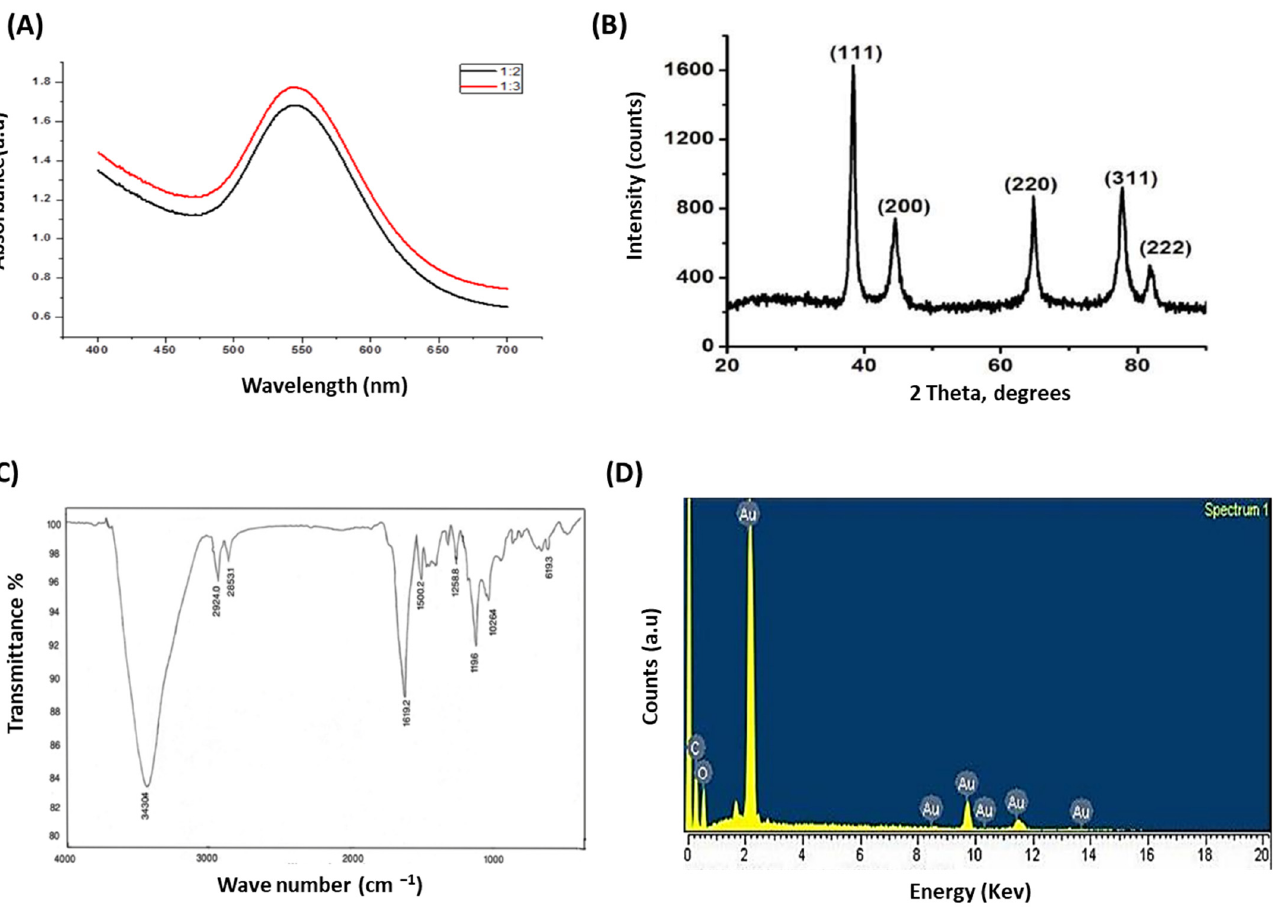
Figure 2. Confirmation of biosynthesized LH-AuNPs. ( A ) UV–Vis spectrum of LH-AuNPs. Different ratios give different absorption peaks, but the most extreme peak with maximum absorbance was recorded 1:2 on 544 nm. ( B ) XRD spectrum recorded for LH-AuNPs showed clear peaks of cubic phases at 38.2 (111), 44.3 (200), 64.9 (220), 77.5 (311), and 81.5 (222), which confirms the crystalline nature of AuNPs. ( C ) FTIR spectrum of LH-AuNPs exhibited two peaks related to OH/NH and C=O groups. The presence of OH group could be ascribed to peak at 3444.6 cm − 1 . The peak of 1732.0 corresponded to C=O group. ( D ) EDX spectrum of LH-AuNPs shows strong signals in the gold region and confirms the formation of gold nanoparticles. A strong peak was displayed around 2.40 keV, which is the characteristic of gold nanoparticles.